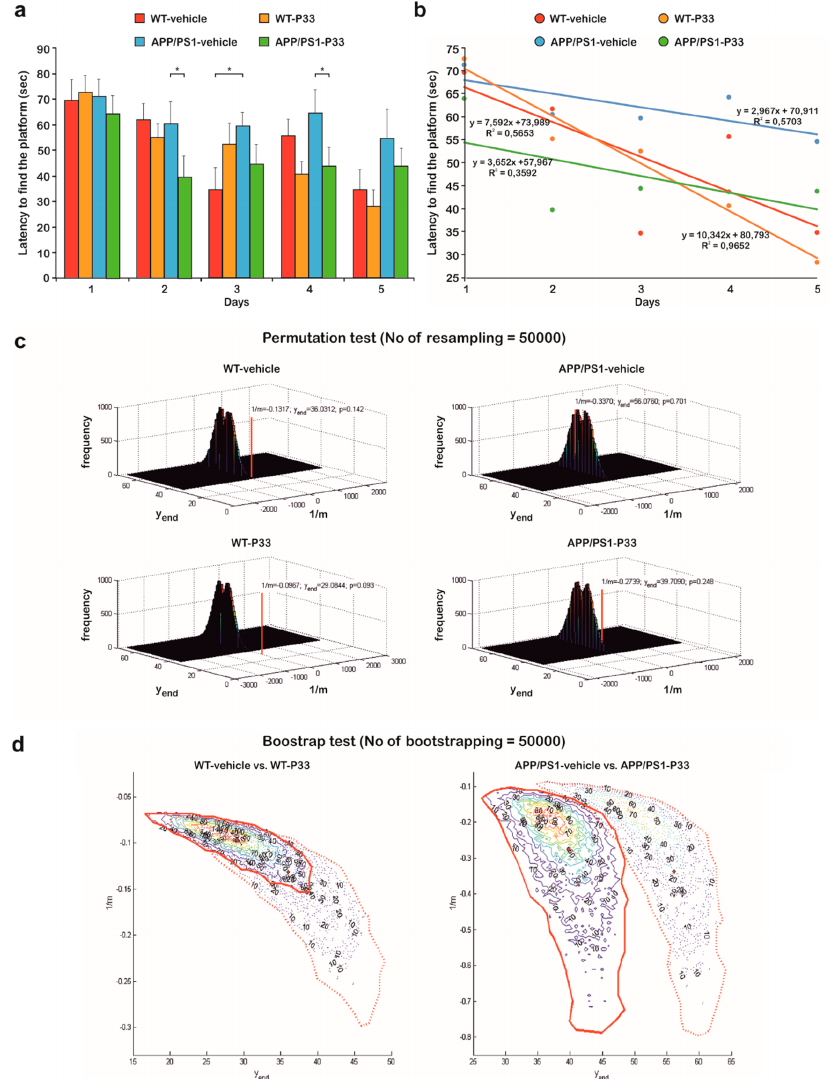
Figure 7. Statistical analysis of the behavior studies. ( a ) The uncertainty and the trend of every latency data versus days on a bar chart. (* represents significant di ff erences at the following p -levels: F 3,181 = 3.365, p = 0.030; APP/PS1 vs WT-vehicle, WT-P33, APP/PS1-P33, p = 0.033, 0.015, 0.006, respectively) ( b ) Former latency data to find the platform in seconds against days. For each case, trend lines were fitted onto the average swimming times. The fitted equations and the determination coefficient ( R 2 ) values are also shown. ( c ) Three-dimensional (3D) distribution results of the permutation tests. WT mice results are significantly different from randomness (positions of the red lines fall far from the distribution of the randomly generated data), while the APP/PS1-vehicle treated mice measurements can be considered as a random event generation (positions of the red line fall in the distribution of the randomly generated data). P33-treatment led to a significant improvement, as the randomness of the measurements was drastically decreased. ( d ) Two-dimensional (2D) contour diagrams of wild-type and transgenic group data distributions based on bootstrapping. The left panel depicts that the WT groups have a high intersection area (32% and 89% of the total areas in case of vehicle and P33-treatments, respectively), indicating that there is no significant di ff erence in the two descriptive parameters between the groups; both were able to learn the task similarly. On the right panel, in case of the APP / PS1 groups, the intersection area is small (approximately 2% of the total areas of both vehicle and P33-treatments), which indicates a significant di ff erence in the parameters between the groups, emphasizing the di ff erence in the learning abilities of the P33-treated vs. non-treated